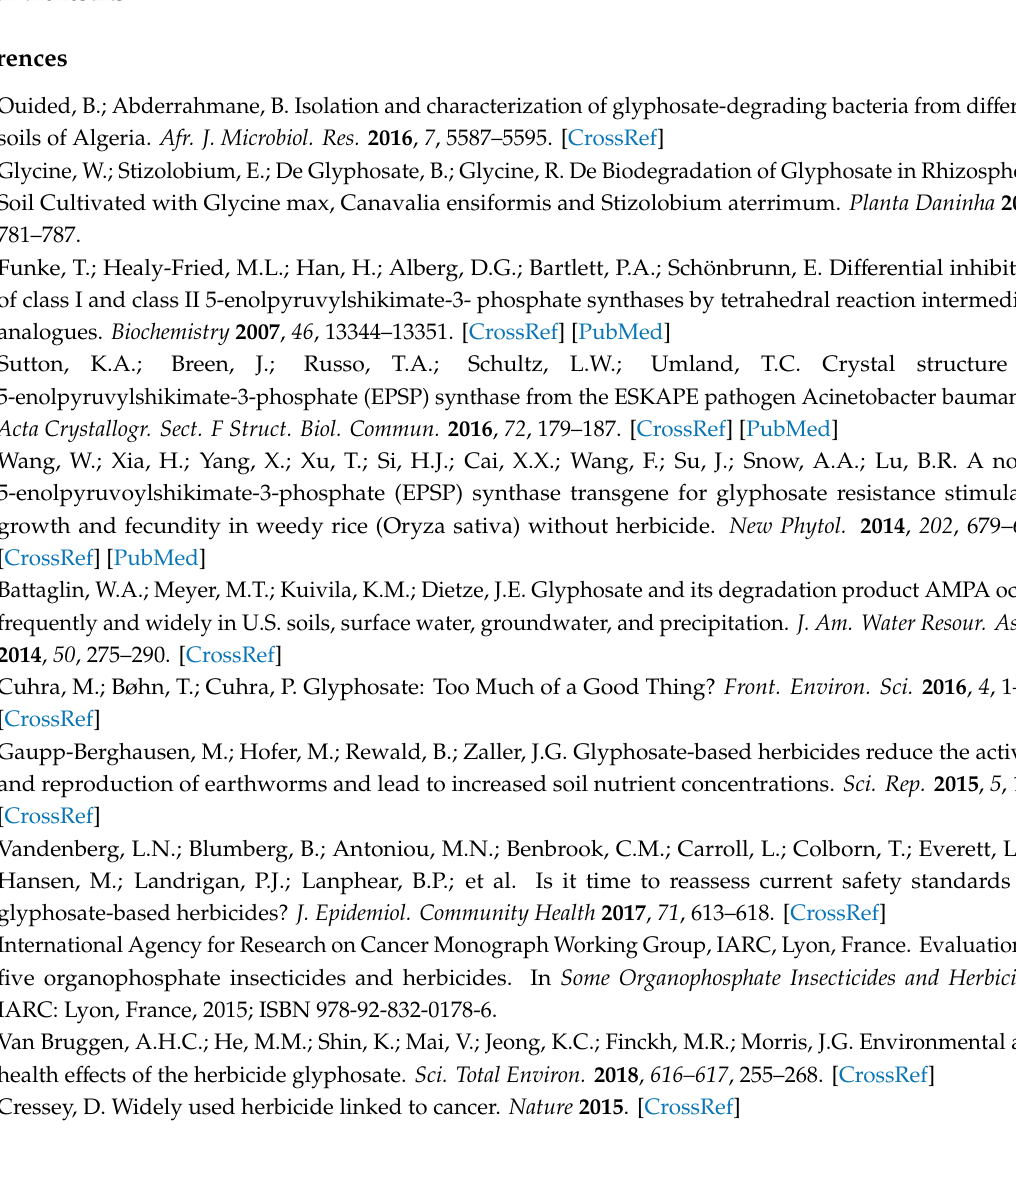
Figure S1: Glyphosate UHPLC-MS / M chromatograph; Figure S2: AMPA UHPLC-MS / M chromatograph; Figure S3: Glyphosate concentration linear regression model. Table S1: Statistical analysis of soil nitrate concentration by day; Table S2: Post-hoc analysis of soil nitrate concentration; Table S3: Statistical analysis of soil ammonium concentration by day; Table S4: Post-hoc analysis of soil ammonium concentration; Table S5: Glyphosate determination by the ninhydrin reaction; Table S6: Statistical analysis of relative follicular area by